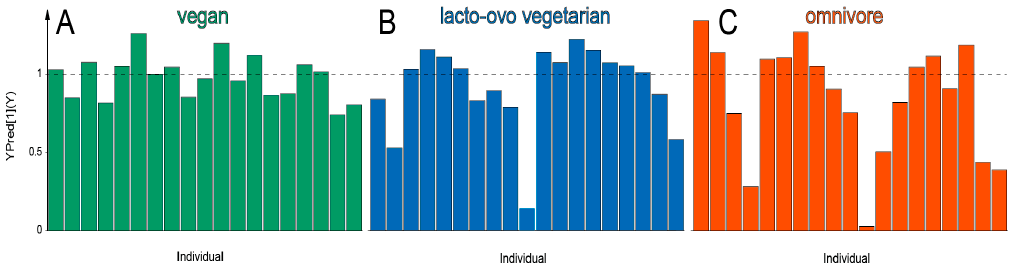
Figure 2. Predicted values in relation to response vector (Y) for volunteers consuming vegan ( A ), lacto-ovo vegetarian ( B ) and omnivore ( C ) breakfasts in orthogonal projections to latent structures with effect matrix (OPLS-EP) models. The dotted line (Y = 1) indicates the response vector value for the models. The magnitude of the predicted effect for each volunteer is given by the height of the corresponding bar. Deviations from the value 1 for a specific volunteer indicate a larger (>1) or smaller (<1) metabolic effect (difference between fasting and postprandial state) in the model direction (metabolic profile) associated with the metabolism of foods included in the different breakfast meals. Each model included 19 observations (equal to number of individuals in the models) and 196 variables. The individual orders of predicted values are not comparable between models.